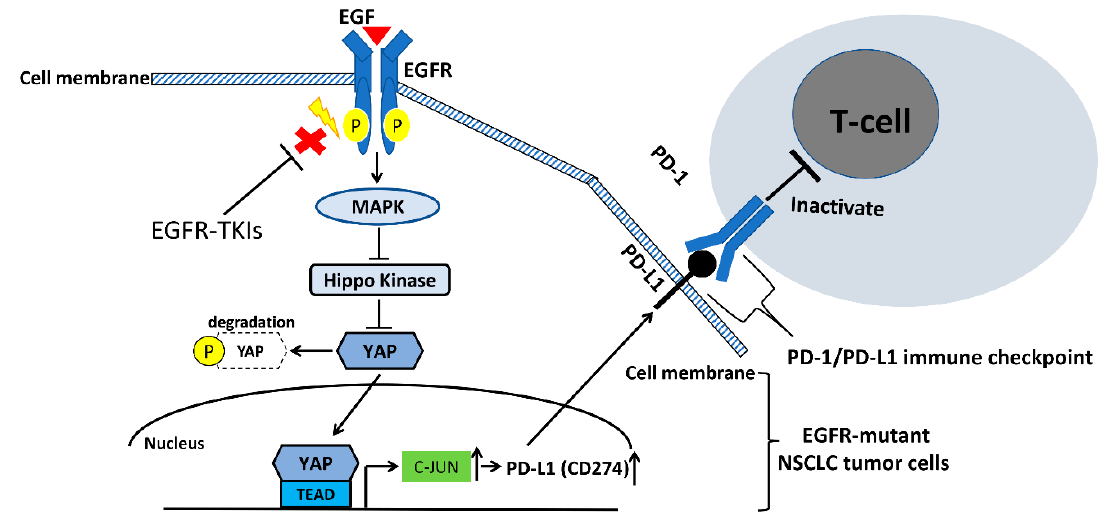
Figure 3. The EGFR pathway regulates PD-L1 expression in NSCLC. Stimulation of EGF or activation of EGFR kinase domain induced PD-L1 expression may be through the activating Hippo / yes-associated protein (YAP) signaling pathway in human NSCLC cells. Inhibition of EGFR by EGFR-TKIs downregulates PD-L1 expression in human EGFR-driven NSCLC cells.